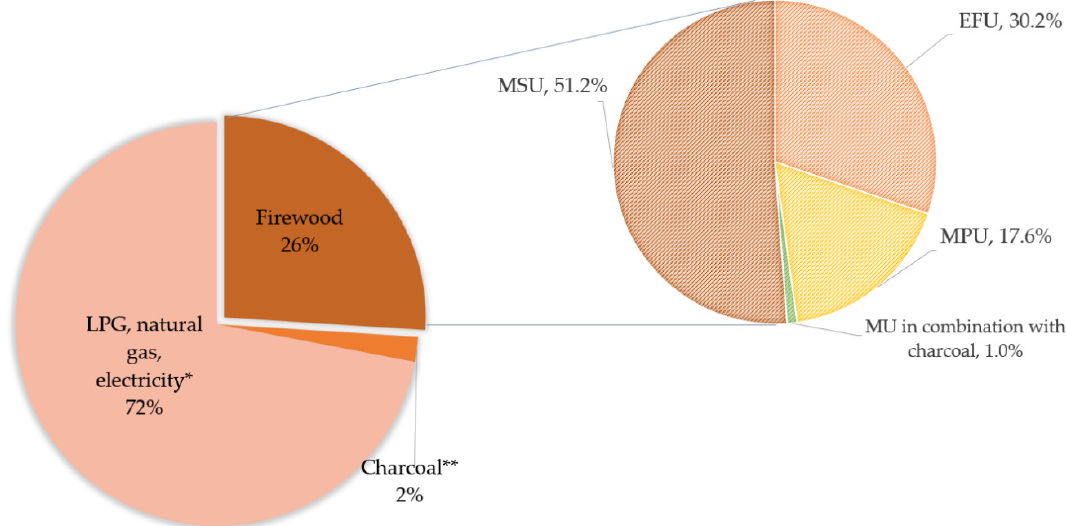
Figure 4. Distribution of households reporting use of firewood for cooking in the ENCEVI survey. * Consumption represents the use by households of these fuels that can be exclusive or in combina- tion with each other. ** Figure reflects exclusive consumption of charcoal, as well as use of charcoal in combination with LPG, natural gas, or electricity. Source: Own elaboration.